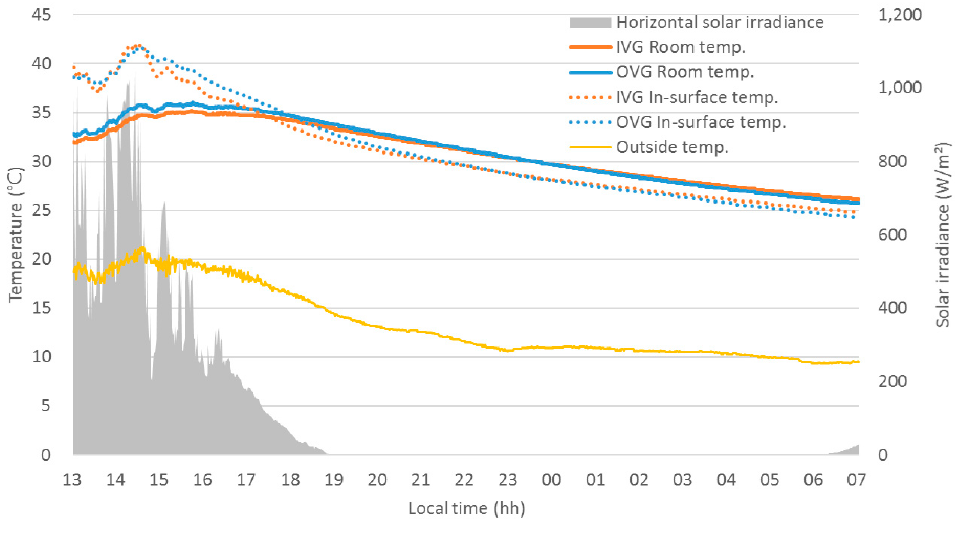
Figure 6. Measured temperature profiles with the IVG and OVG (6–7 April 2017).